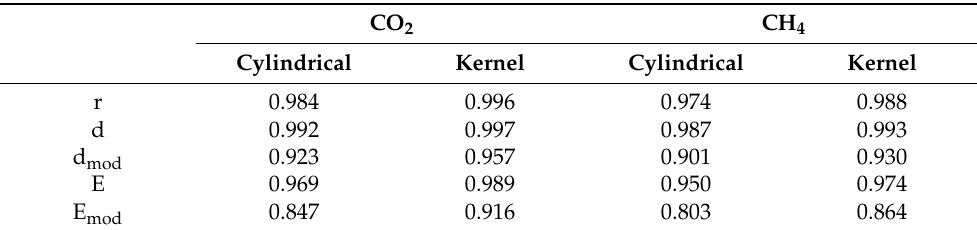
Table 3. Statistics used to compare mean and modelled daily cycles.